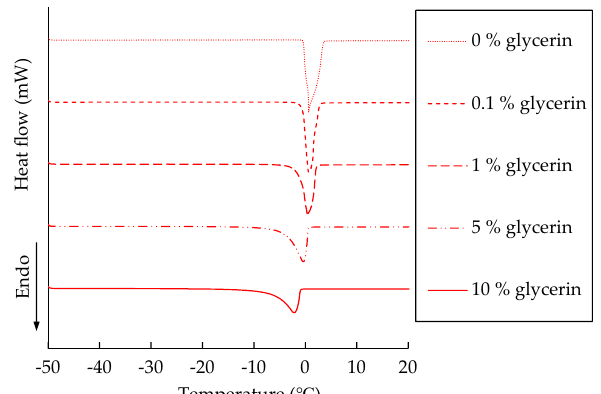
Figure 7. Heating curves of DSC thermograms at a 1 °C/min scanning rate for glycerin solutions with the concentrations of 0–10 wt%.